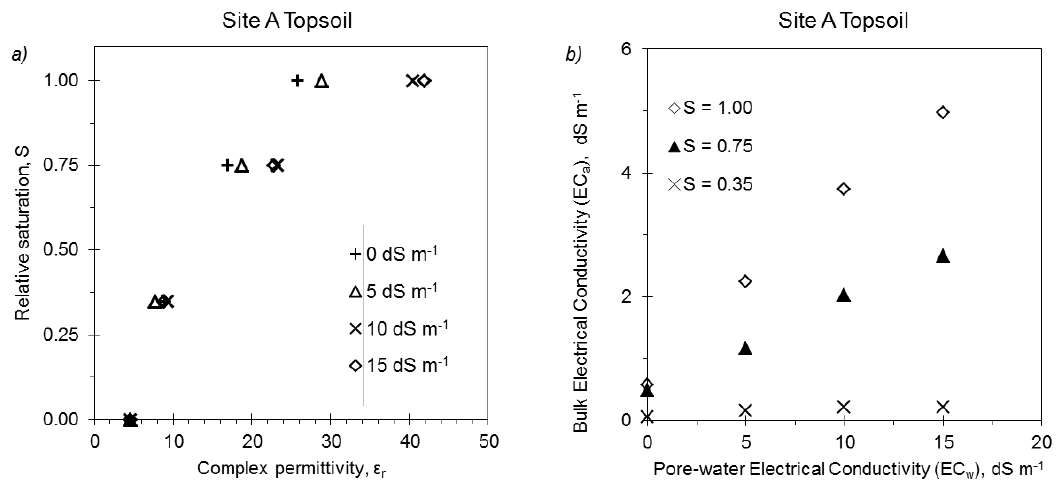
Figure 2. Site A, topsoil: ( a ) relative saturation vs. measured complex permittivity for four EC values of the wetting solution; ( b ) influence of EC w various relative saturation levels.